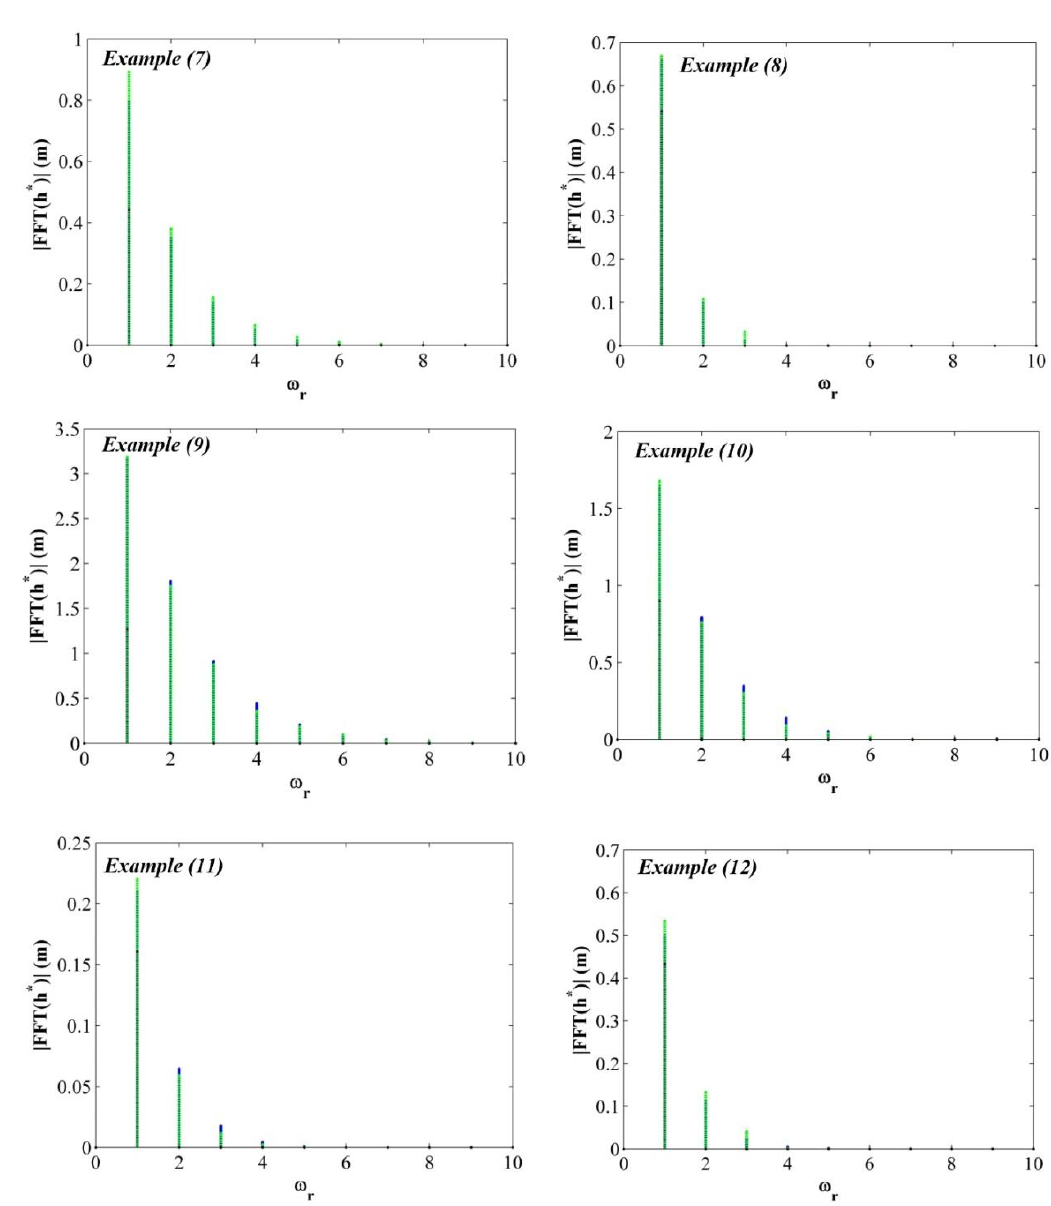
Fig. 8 Responses of the examples in the frequency